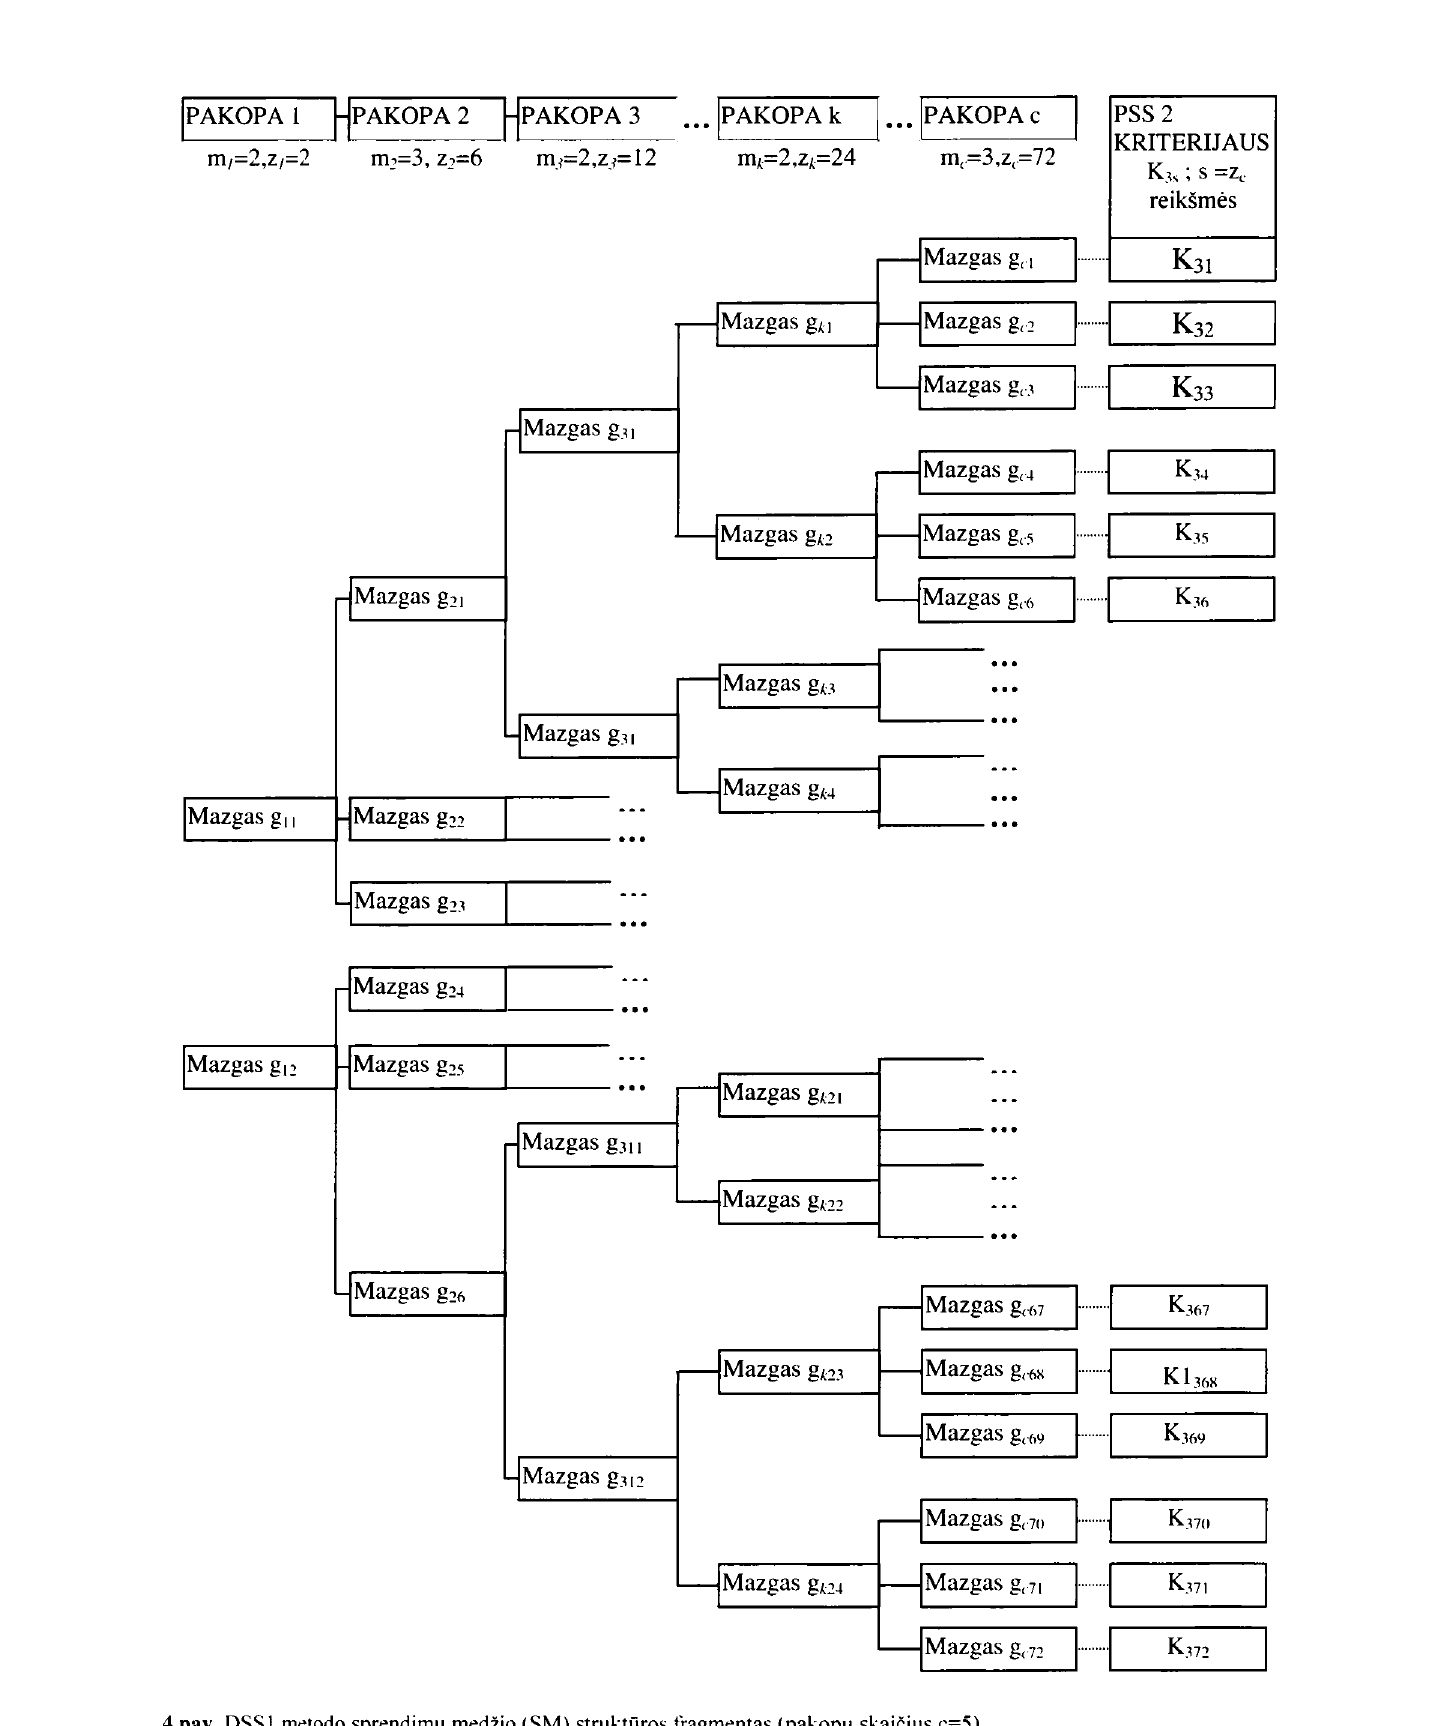
Fig 4. Fragment of decision tree formation structure with multicriteria project synthesis method DSS I